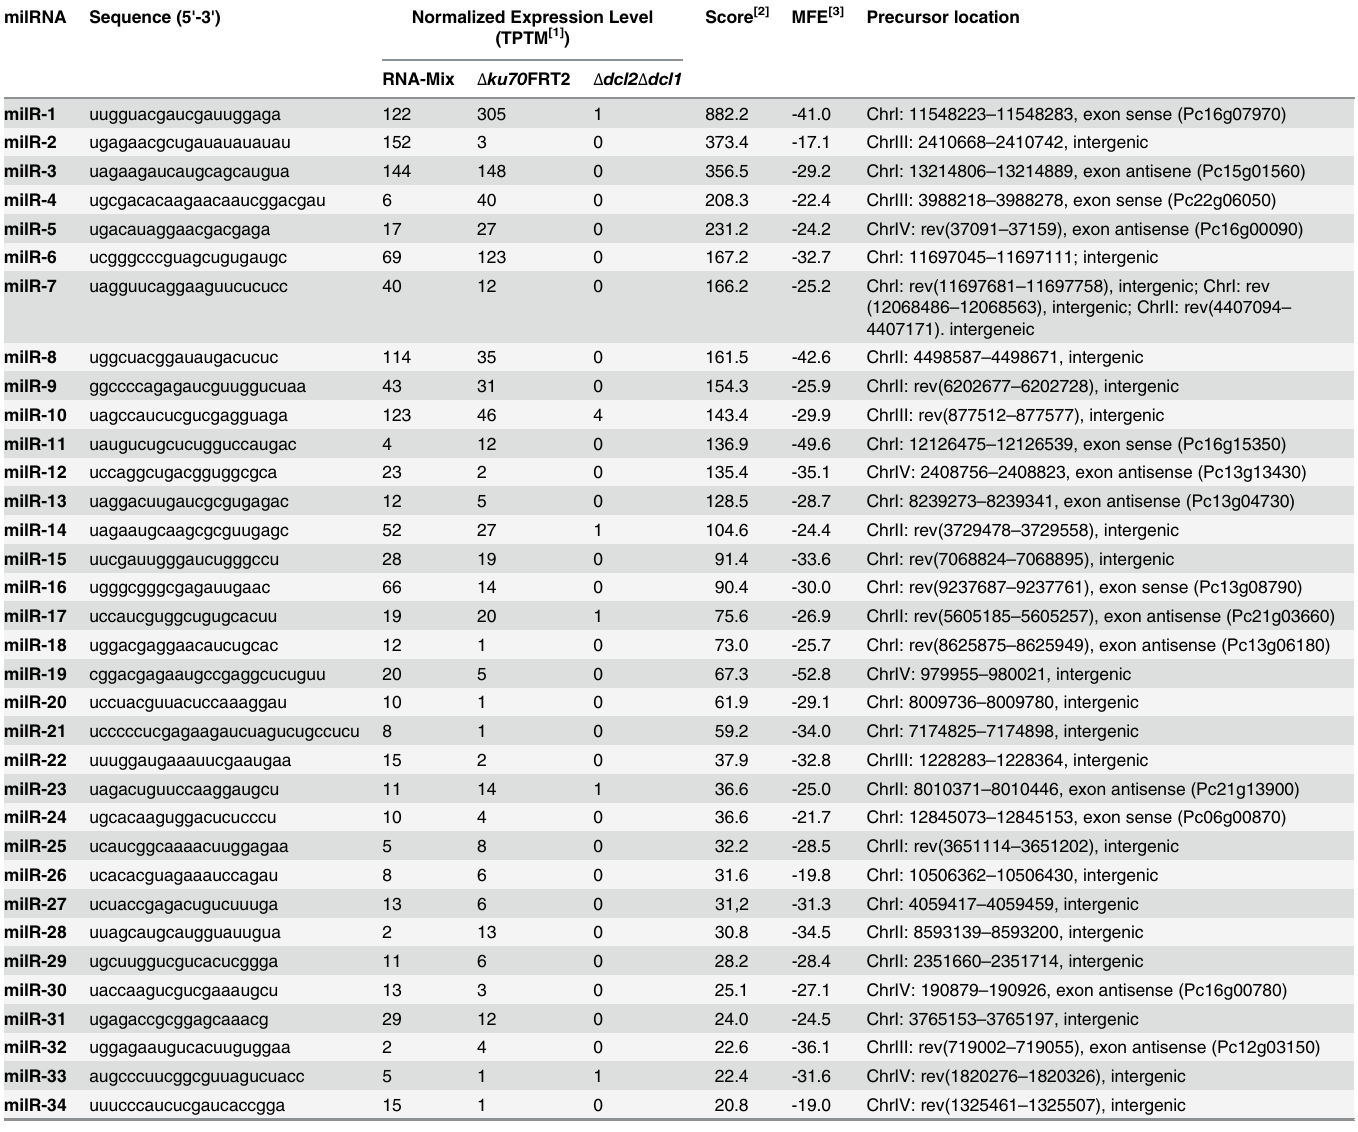
Table 3. Predicted milRNAs and the appearance of their reads within the three datasets. milRNA Sequence